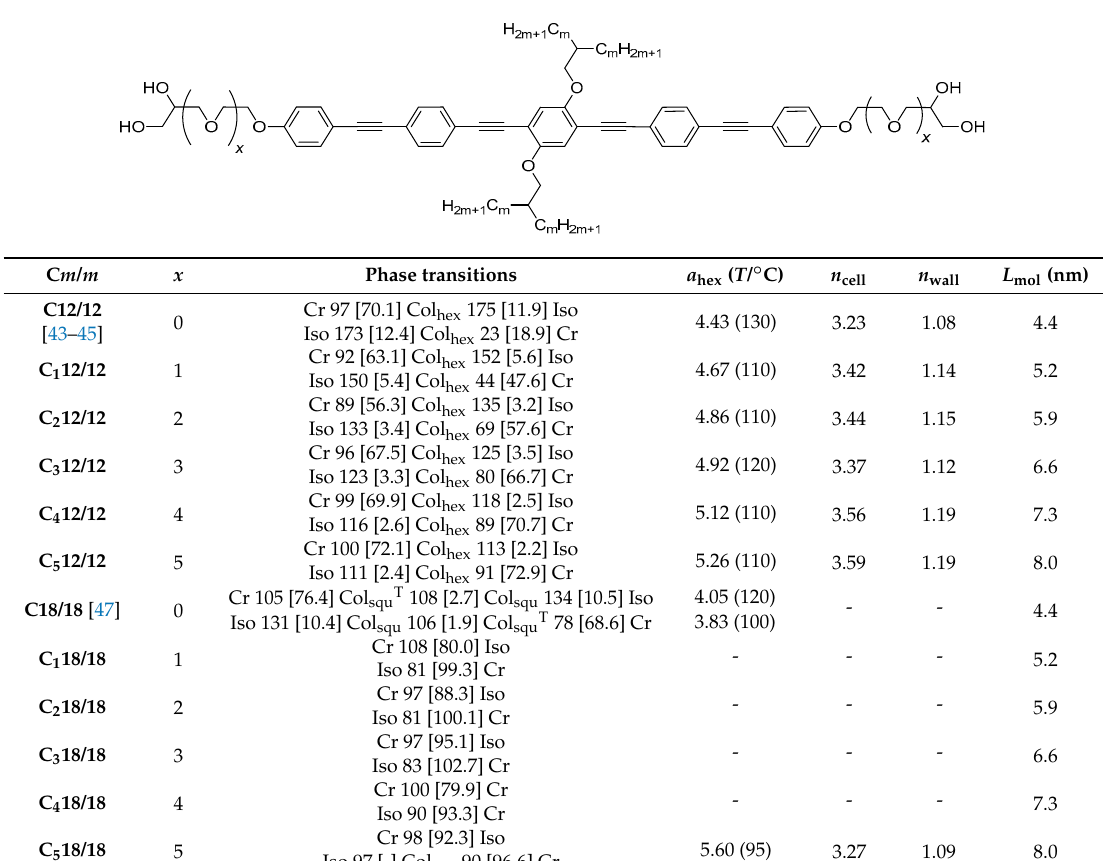
Table 3. Comparison of the mesophases, and phase transition temperatures ( T /°C), as observed on heating (top lines) and cooling (bottom lines), the corresponding enthalpy values ( Δ H /(kJ·mol − 1 ), in square brackets), and other data, of compounds C x 12/12 and C x 18/18 , depending on the number of EO units x a .